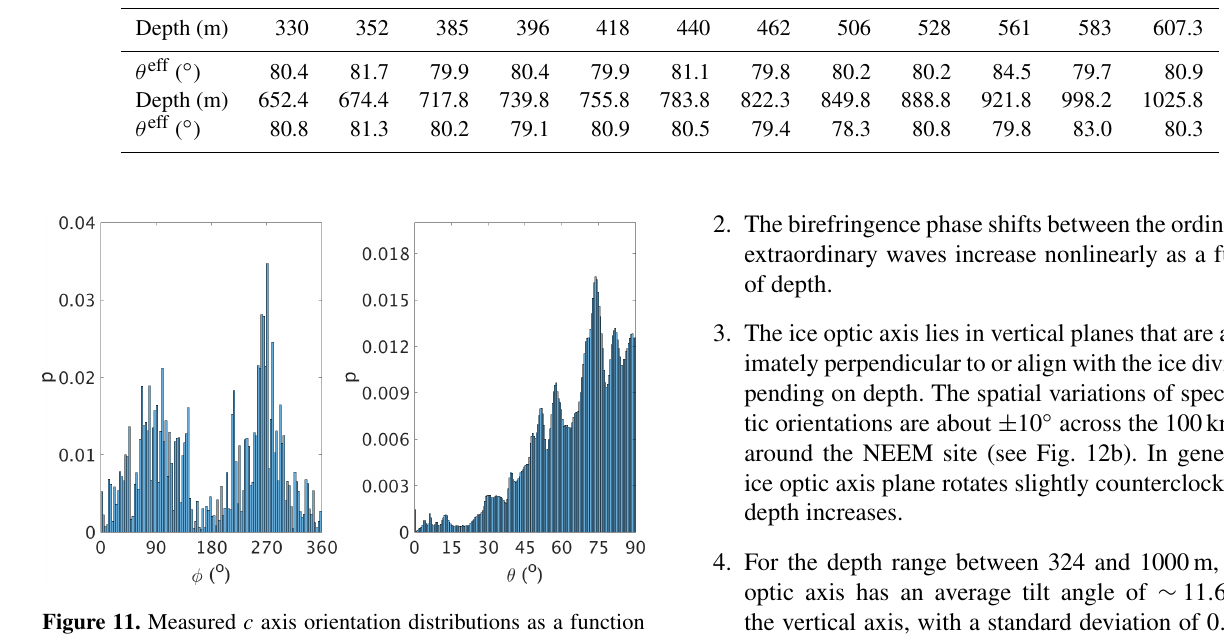
Table 2. Effective colatitudes θ eff ( ◦ ) calculated from COF measurements at different depths